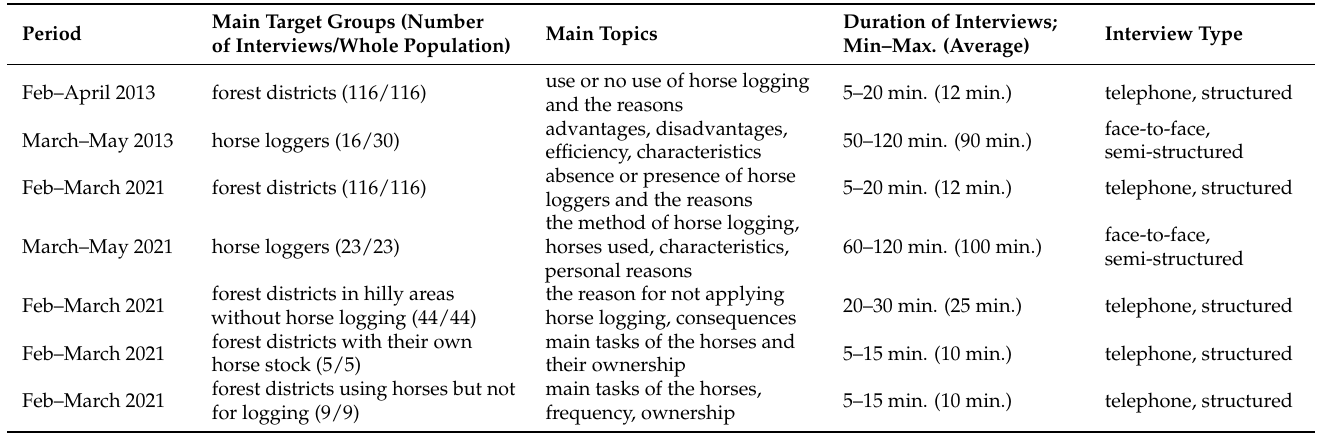
Table 1. Main characteristics of the